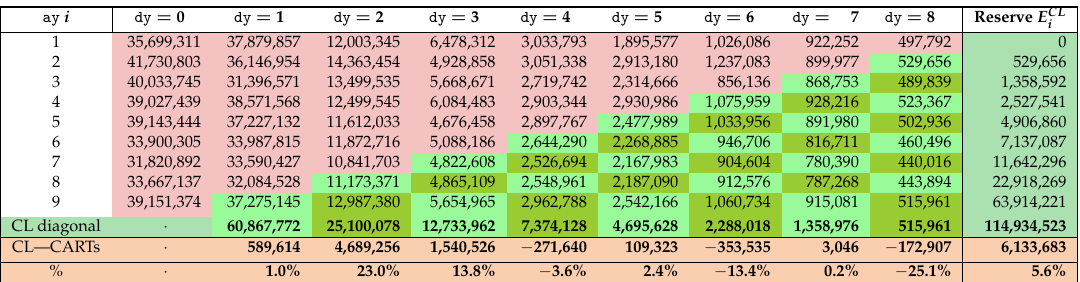
Table 10. Chain-ladder reserve estimates on aggregate payments (type-1 + type-2, incremental figures). The differences with the CARTs estimates are also